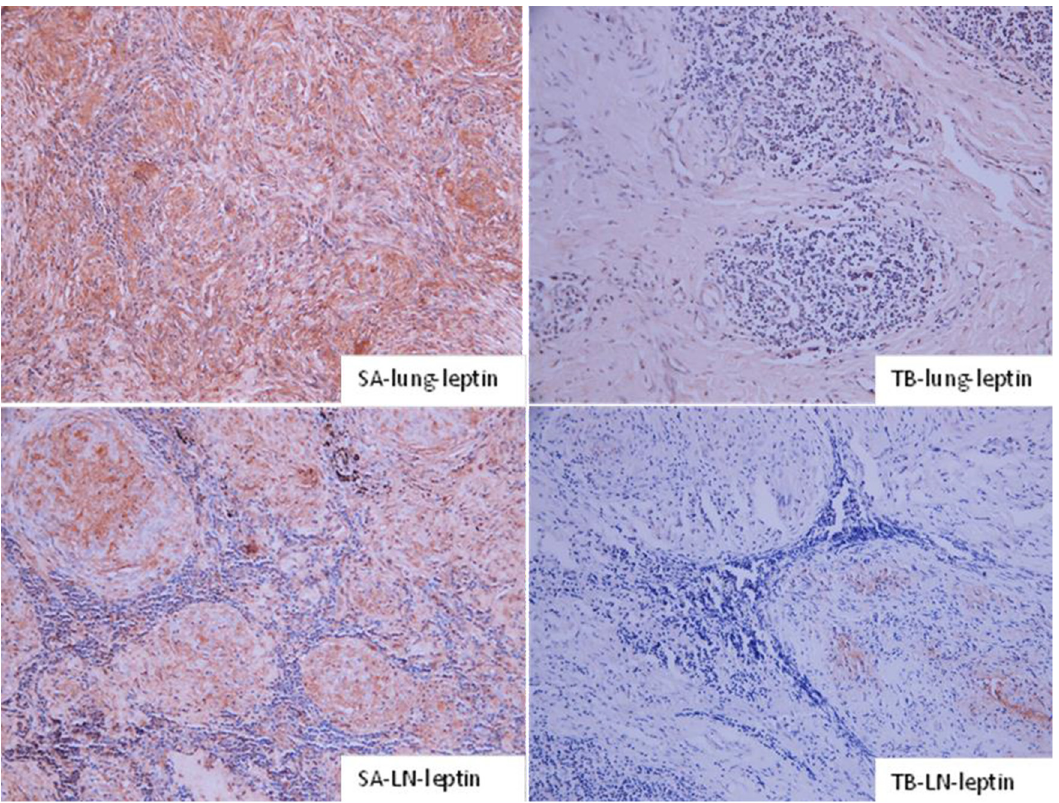
Fig 4. IHC analysis of lung sections from patients in the SA and TB groups. Staining for leptin is shown (×200). In the SA group, leptin exhibited positive expression in the lung and was scattered in the granuloma and its adjacent tissues. In the TB group, it showed nonspecific staining, although some hazel-colored regions could be imaged in the adjacent tissues. Leptin accumulated in the center of the lymphoglandulae granuloma in the SA group, exhibiting strong positive expression, while that in the TB group showed significantly weaker expression (Fig 2).